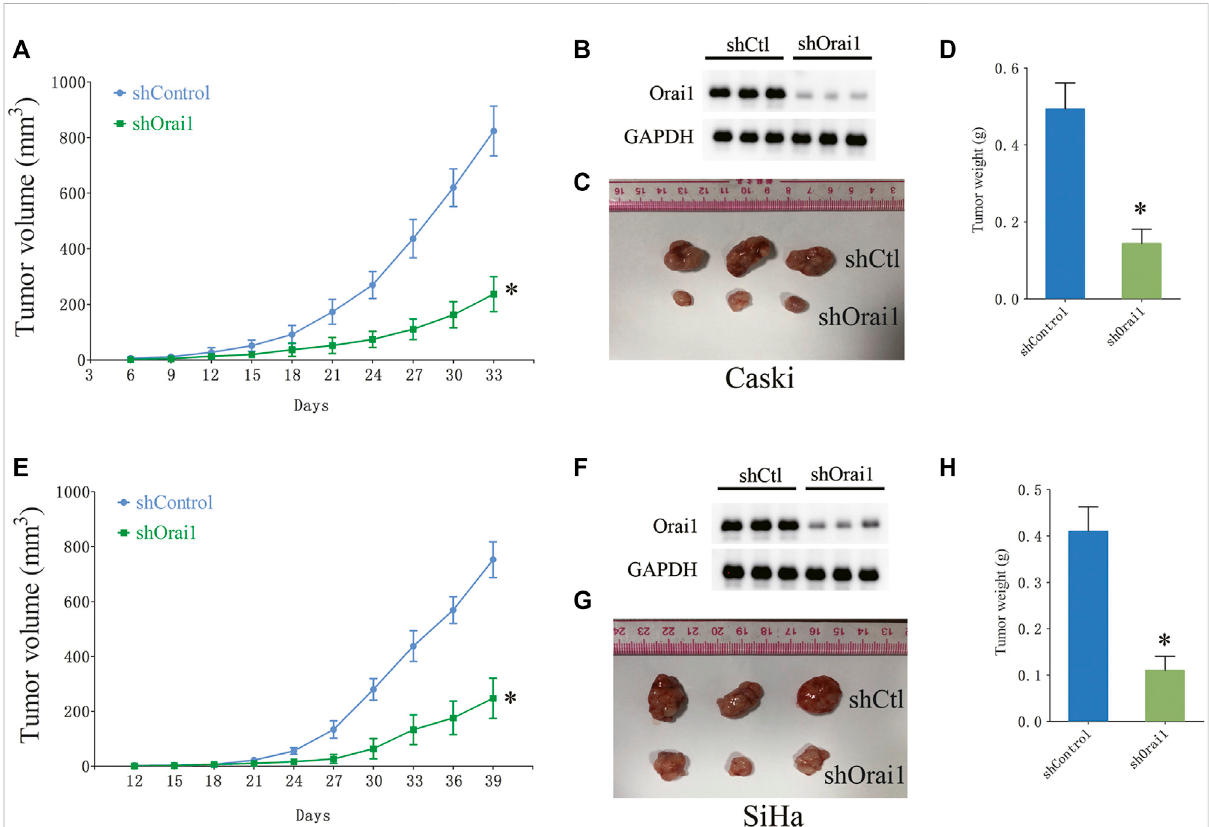
FIGURE 4 Orai1downregulationsuppressedcervicalcancer invivo . (A) ThegrowthcurveofthexenograftsderivedfromCaskicellsstablytransfectedwith scrambled-shRNA (shCtl) or Orai1-shRNA (shOrai1). The tumor volumes were measured once every 3 days. (B) Immunoblot showing Orai1 protein levels in the sh-Orai1 xenografts. (C – D) Representative images and the average weight of Caski cells-derived tumors. (E) The growth curve of the xenografts derived from SiHa cells stably transfected with sh-Ctl or sh-Orai1. The tumor volumes were measured once every 3 days (F – H) Representative images of the tumors and in situ Orai1 expression, and the average tumor weight. Values are means ± SEM, * p < 0.05 compared to shCtl